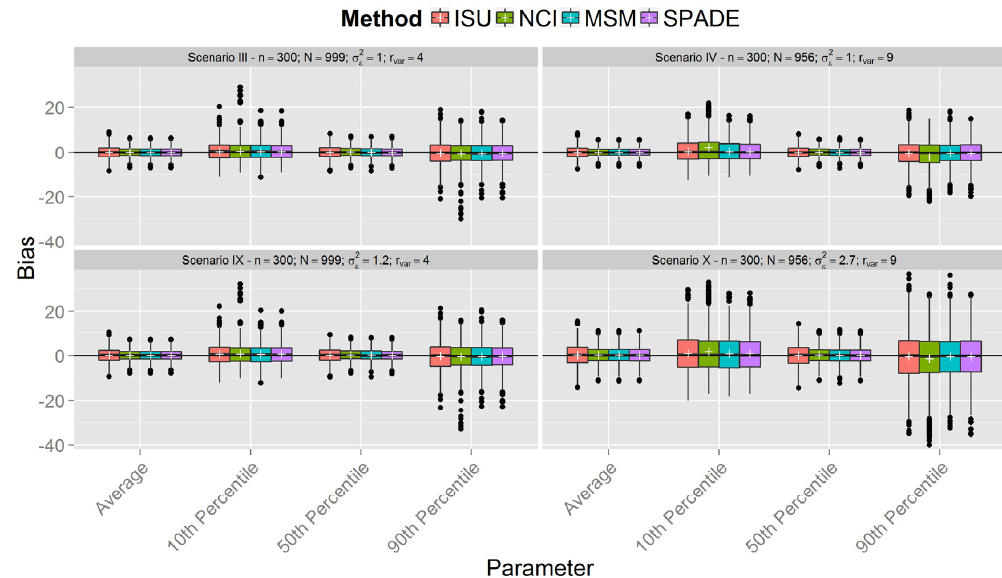
Figure 2. Boxplot of biases calculated for each method and scenarios with n = 300 for samples with estimated between ‐ person variance different from zero for all methods (N denotes the number of usable samples).